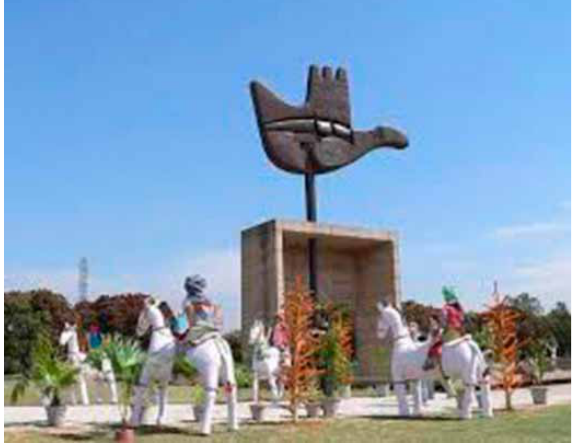
fig. 2. The open Hand monument at Chandigarh (The open Hand Monument